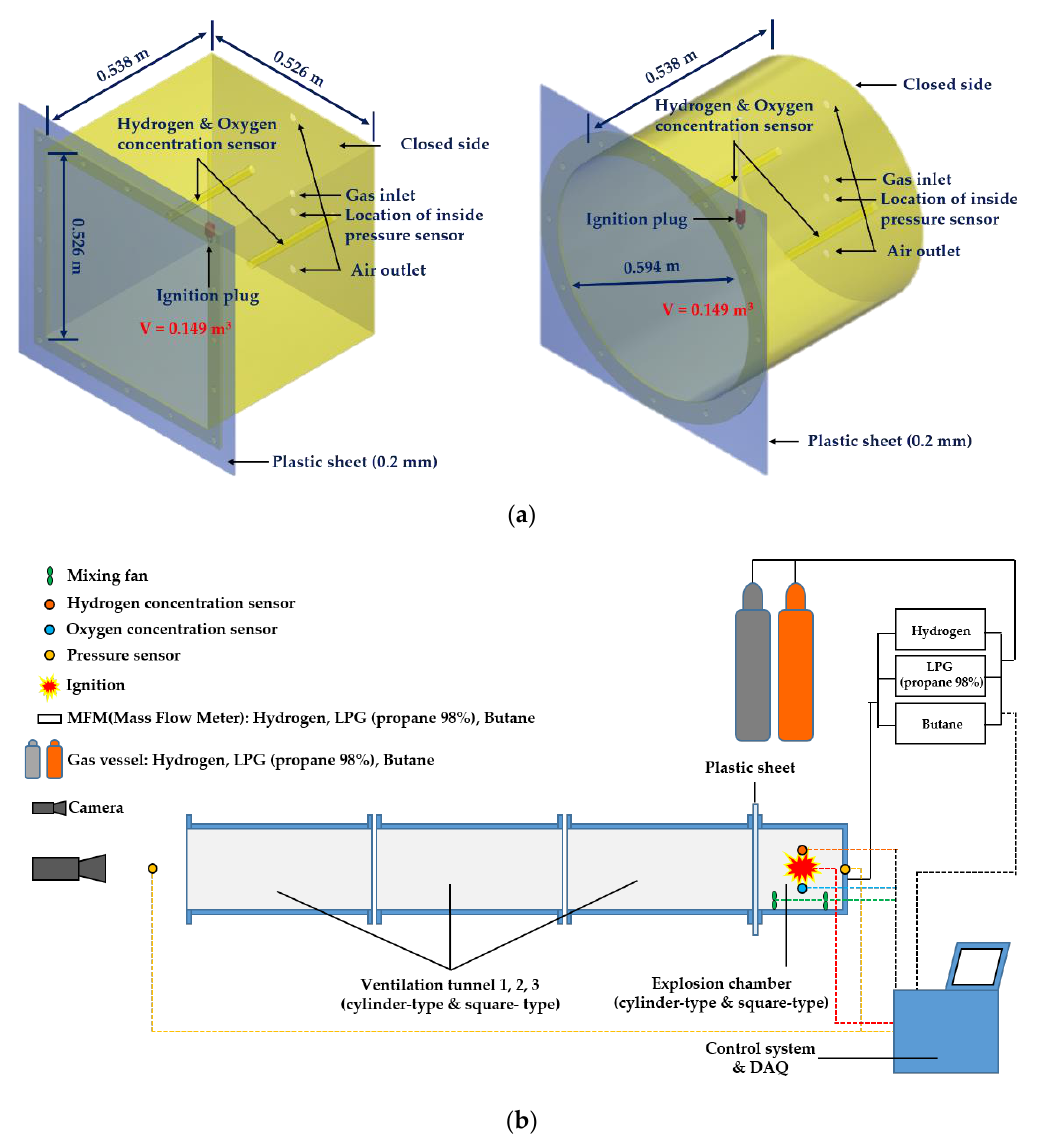
Figure 2. Schematic representation of the test facility; ( a ) explosion chamber (left: square-type, right: cylinder-type), ( b ) Test facility.